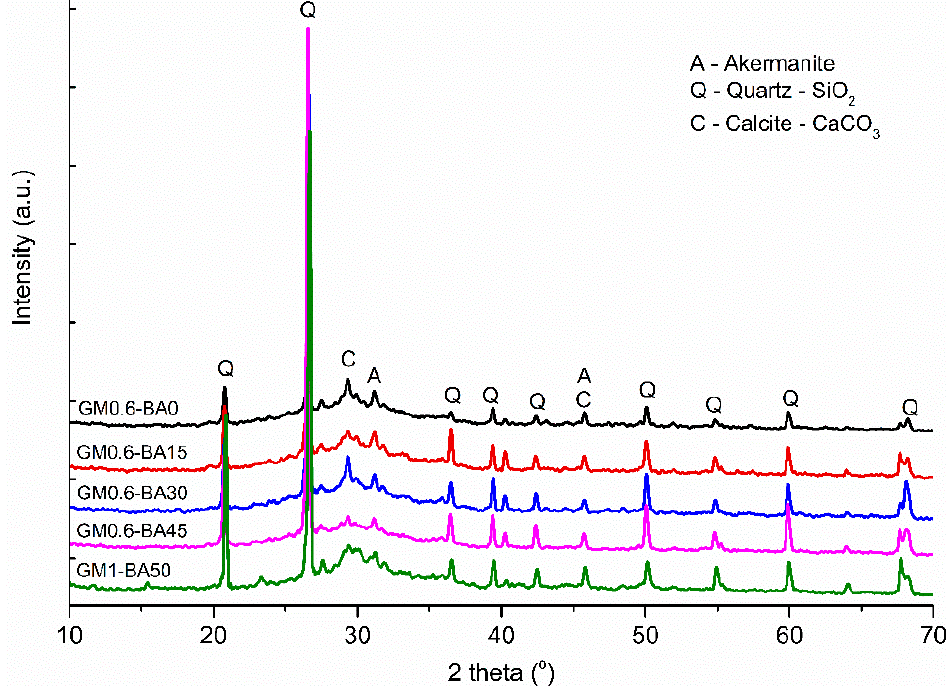
Figure 6. XRD pattern of AA paste samples.